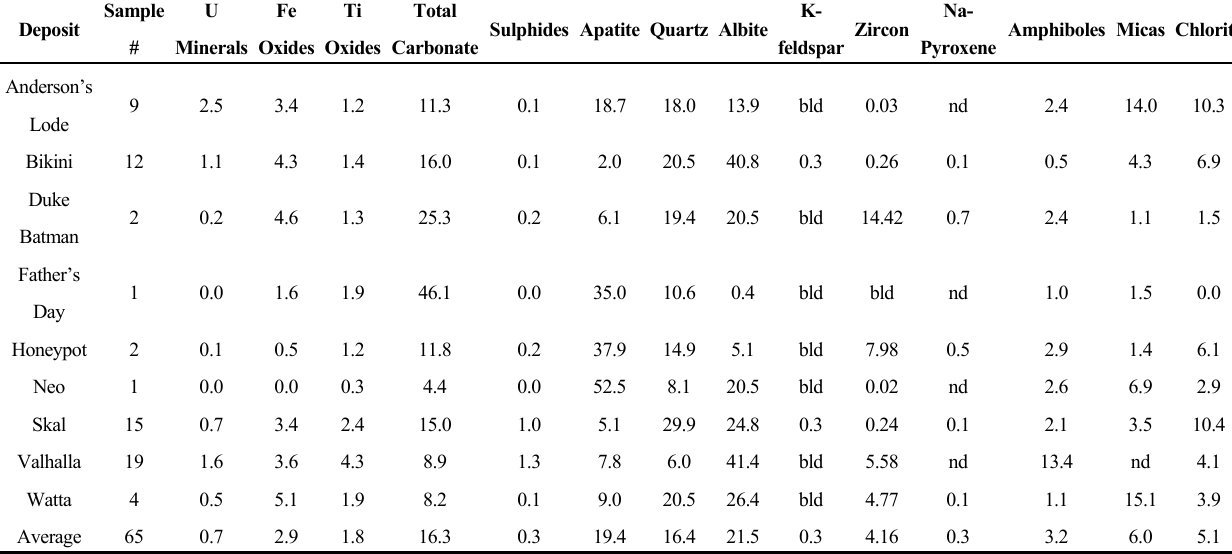
Table 3. Quantitative QEMSCAN modal analyses of gangue minerals from samples of nine uranium deposits from Mount Isa. Note that QEMSCAN did not detect aegirine in samples from Valhalla, although this mineral was detected using the